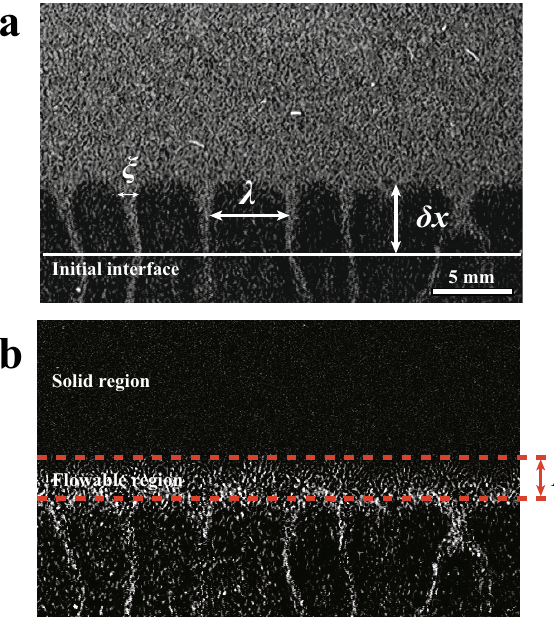
Figure 5. Characteristic parameters for both systems. ( a ) The distance moved by the interface from an initial position, δ x ; thickness of the region which can flow, L ; the mean distance between the fingers, (cid:31) ; width of the fingers, ξ . The number of the fingers is about 40 at the beginning and it is more than 10 at the end of the experiment. The standard deviation of (cid:31) is at most 10%. ( b ) The difference between two consecutive images. L is thickness of the region which can flow. Solid region is located above the flowable region. Near the interface, the gravitational flow is dominant, but the horizontal flow is